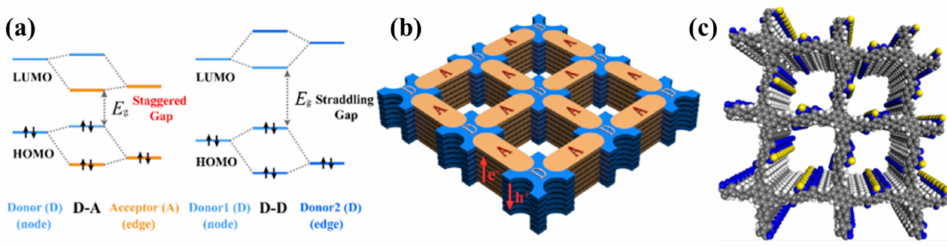
Figure 13. ( a ) Two types of band gap in COFs and corresponding energy level alignment of frontier orbitals in building blocks. ( b ) Schematic illustration of the stacking structure of D-A COFs and the separation of one-dimensional transport channels for electron and hole. ( c ) Stacking structure of PPy-BT. Reproduced with permission from Ref. [57]. Copyright: American Chemical Society,